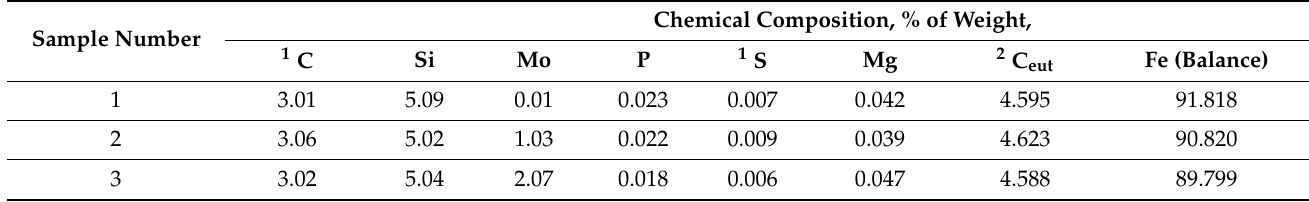
Table 1. Chemical composition of spheroidal cast